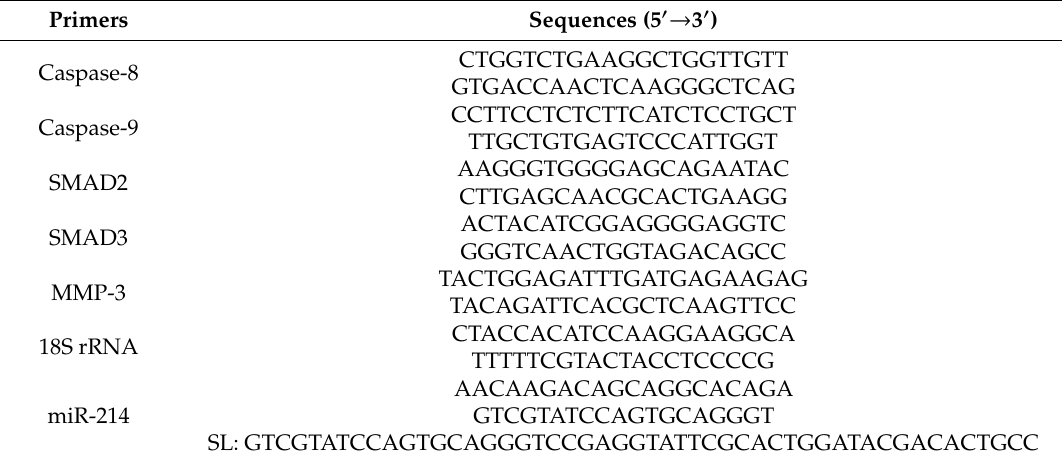
Table 2. The sequence of primers was used in the current